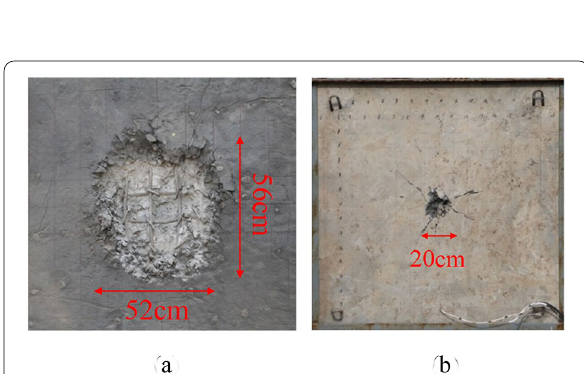
Fig. 10 FC05 slab under 2.5 kg explosion: a the frontal surface and b the back surface.